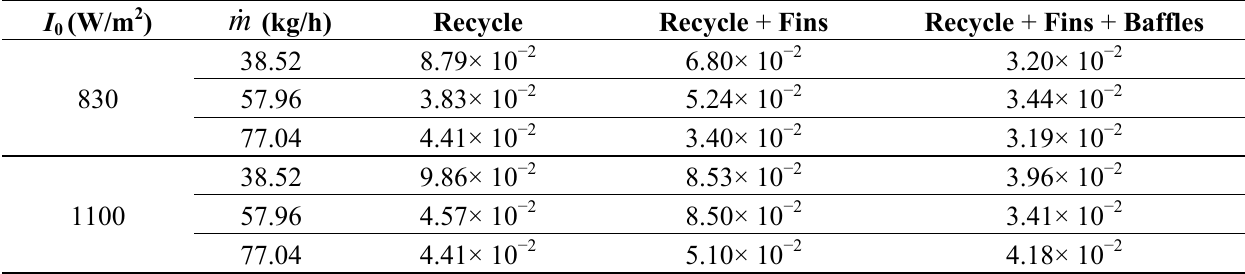
Table 3. Theoretical predictions of heat-transfer efficiency improvement I R